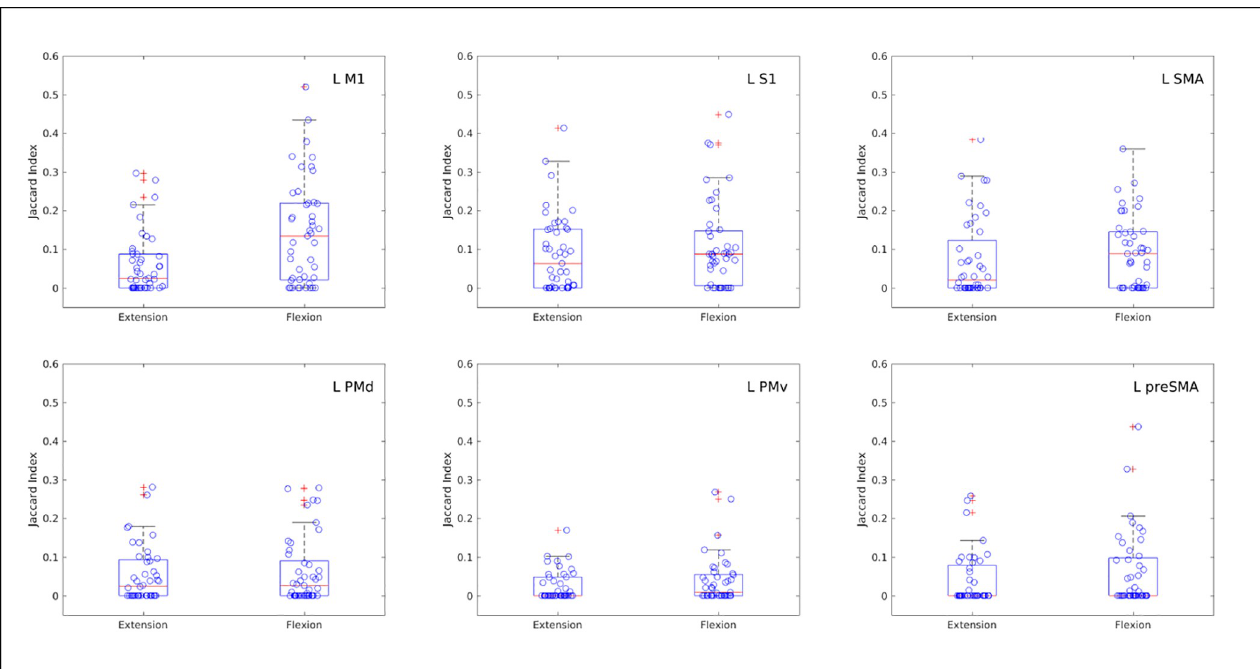
Fig 7. Box plots of the Jaccard index of similarity between pairs of participants’ sets of activated voxels preferring wrist extension or wrist flexion, as evaluated by which action yielded the larger t-statistic. Each Jaccard index of similarity evaluates degree of overlap for two sets of voxel coordinates by calculating the ratio of intersection to union of the sets. For total overlap of two sets, the intersection equals the union so the Jaccard index is 1. Each point represents the index of similarity for voxel sets in MNI common coordinates, derived for the same wrist action, obtained from different participants. All possible pairwise comparisons of the 10 participants are shown. Different panels present results for the six left hemisphere ROIs from the Human Motor Area Template (top row: left M1, left S1, left SMA; bottom row: left dorsal premotor, left ventral premotor, left pre-SMA).